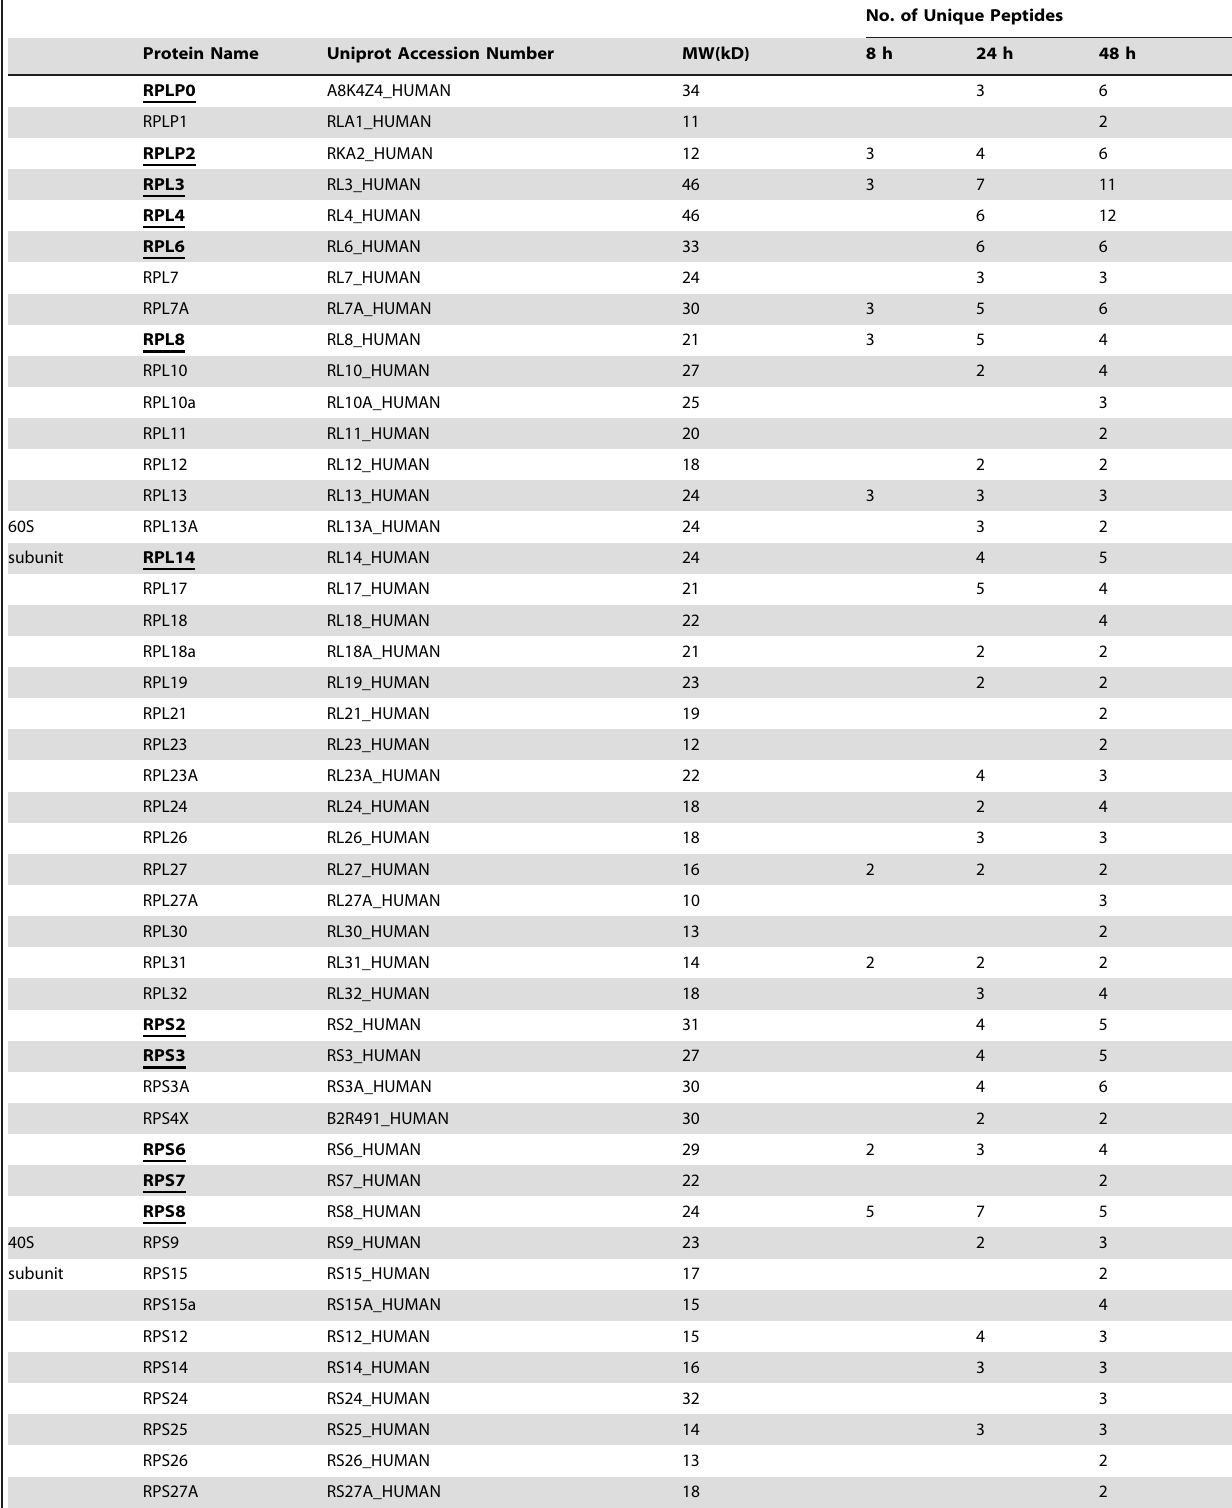
Table 3. Ribosomal proteins indentified in IE2-p86SG associated